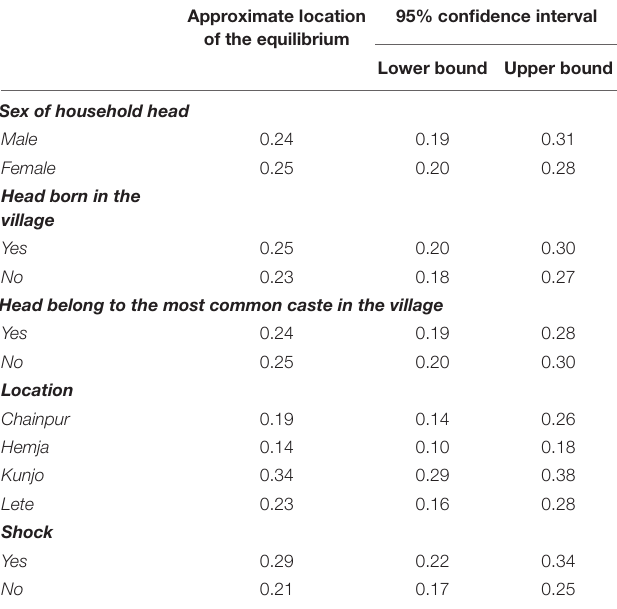
TABLE 1 | Group-specific environmental reliance equilibria identified using local polynomial non-parametric regression, Nepal,